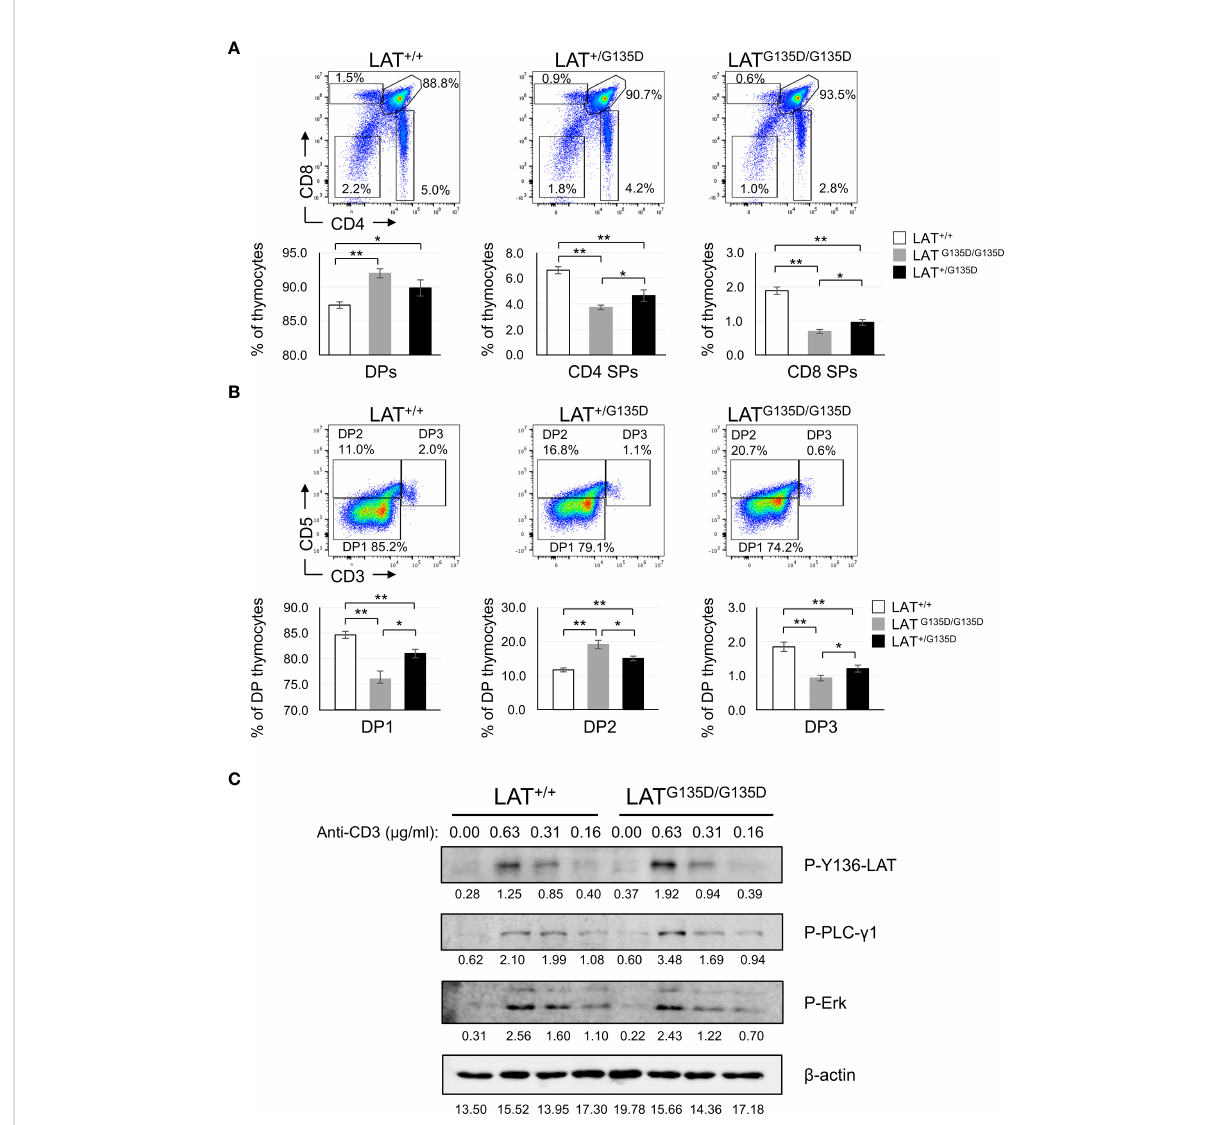
FIGURE 1 Thymic development analysis of LAT G135D mice. (A) Total thymocytes from wild-type (LAT +/+ ), heterozygous (LAT +/G135D ) and homozygous (LAT G135D/G135D ) mutant mice were analyzed for the expression of CD4 and CD8 (upper panels) by fl ow cytometry. The numbers indicated in each gate represent the percentage of cells. Upper panels show a representative experiment. Lower panels represent bar graphs obtained after the analysis of LAT +/+ (n = 15), LAT +/G135D (n = 9) and LAT G135D/G135D (n = 13) mice, showing the percentages of cells in each of the indicated compartments. The brackets on each bar represent the mean standard error. (B) Dot plots showing CD5 and CD3 expression in DP cells from 6 to 14 weeks old wild-type (LAT +/+ , n = 13), heterozygous (LAT +/G135D , n = 8) and homozygous (LAT G135D/G135D , n = 12) mice. Lower panels represent the quanti fi cation of percentages of preselection DP cells (DP1), DP cells undergoing selection (DP2), and post selection DP thymocytes (DP3). * indicates p<0.05; ** indicates p<0.01. (C) Analysis of TCR signaling in thymocytes. 5 x 10 6 fresh thymocytes were obtained from wild-type (LAT +/+ ) and homozygous (LAT G135D/G135D ) mutant mice and incubated with the indicated concentrations of biotin-conjugated anti-CD3 for 30 min, and then stimulated with 10 µg/ml of streptavidin for 3 min at 37°C. Cells were then lysed and analyzed by Western blot with the indicated speci fi c antibodies. Membranes were stripped and reanalyzed with antibodies b -actin to show total protein load. Numbers below the images represent the densitometric quanti fi cation of each